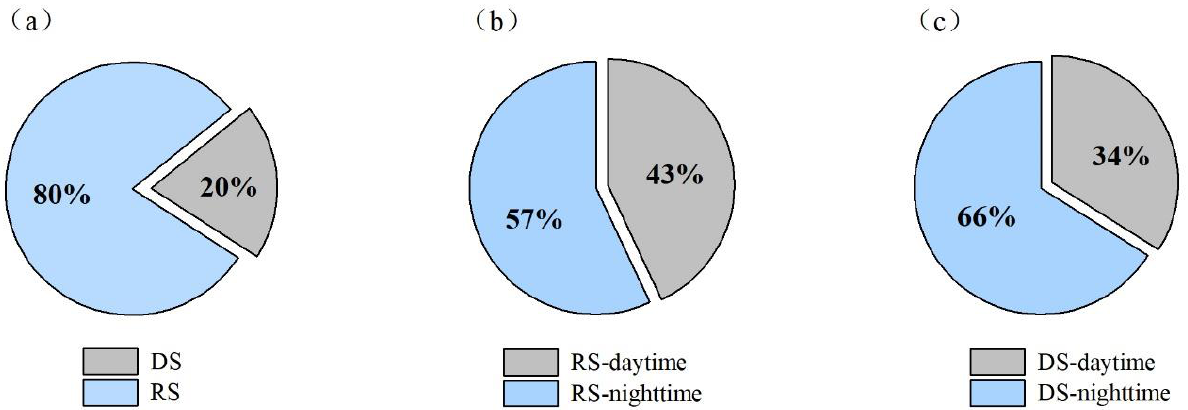
Figure 2. Proportion of average precipitation in different periods. (RS: proportion of precipitation in rainy season, DS: proportion of precipitation in dry season, RS-daytime: proportion of daytime precipitation in rainy season, RS-nighttime: proportion of night-time precipitation in rainy season, DS-daytime: proportion of daytime precipitation in dry season, DS-nighttime: proportion of night-time precipitation in dry season).